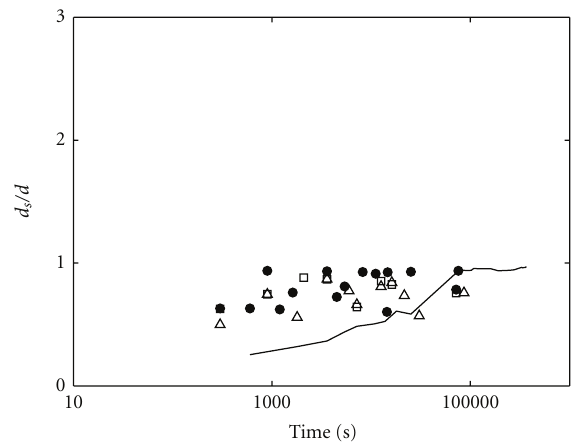
Figure 7: Experimental duration reduction. Canonical and live-bed experiments. I = 1 . 3 no fail (black squares); I = 1 . 3 fail (+); I = 1 no fail (circles); I = 1 fail